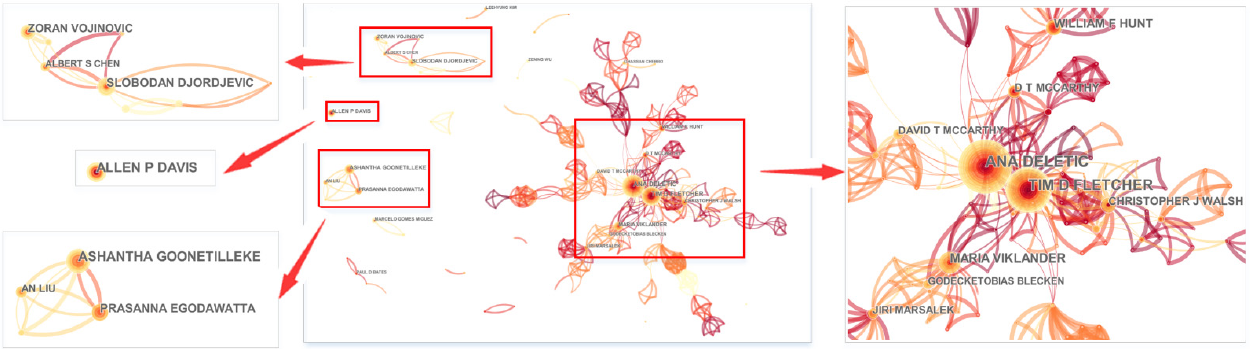
Figure 6. Authors’ cooperation network.